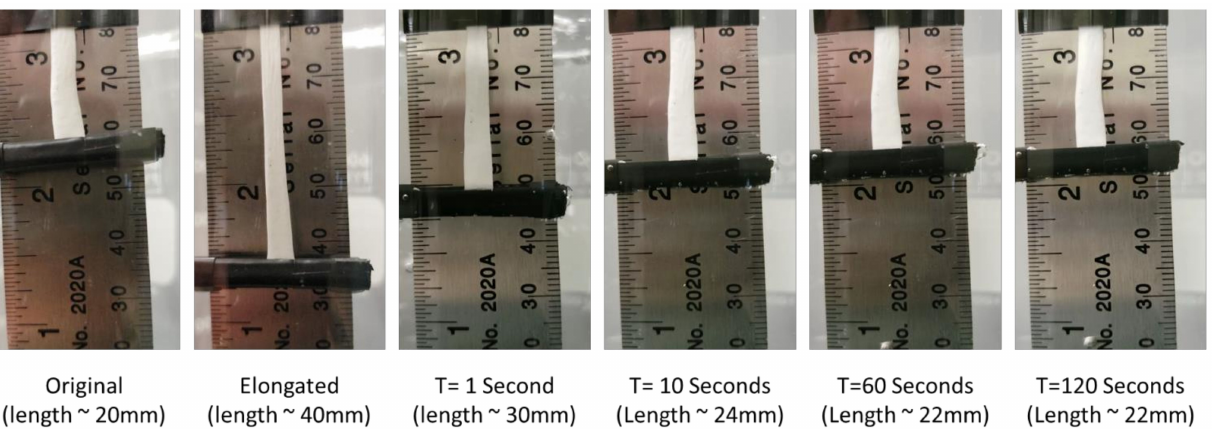
Figure 10. Macroscale shape recovery of 30% Acet, 30 min electrospun samples in 37 ◦ C water. Images show that material recovers rapidly in body-temperature water and achieves approximately 90% shape